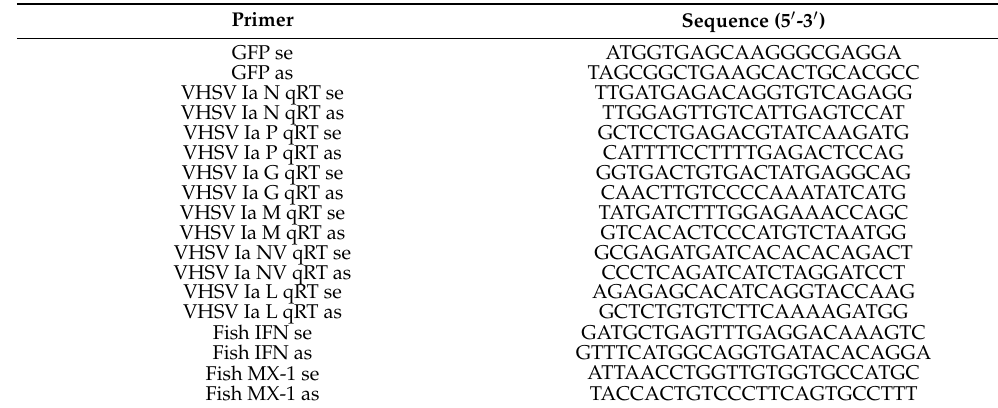
Table 1. Primers for